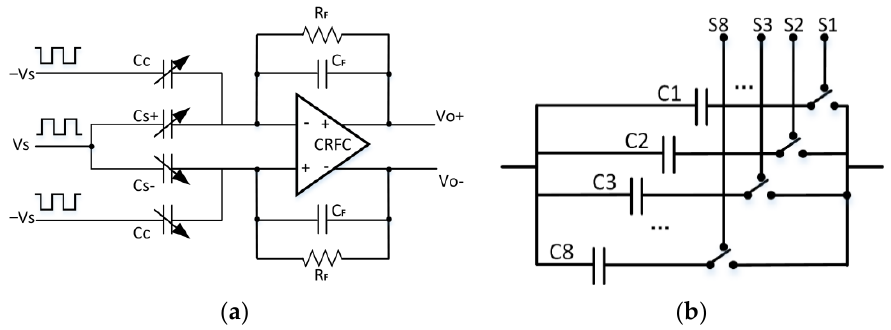
Figure 2. The designed C/V converter based on DC capacitance cancellation. ( a ) Schematic diagram of the charge amplifier for differential capacitance detection; ( b ) DC capacitance cancellation scheme.